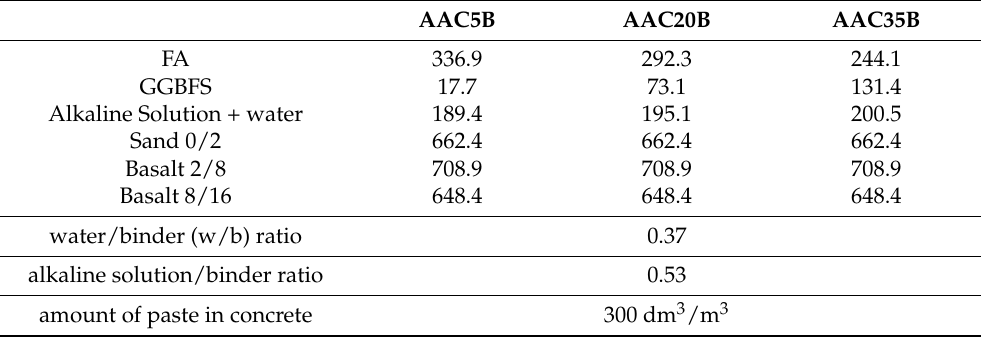
Table 3. Composition of alkali-activated concretes [kg/m 3 ].